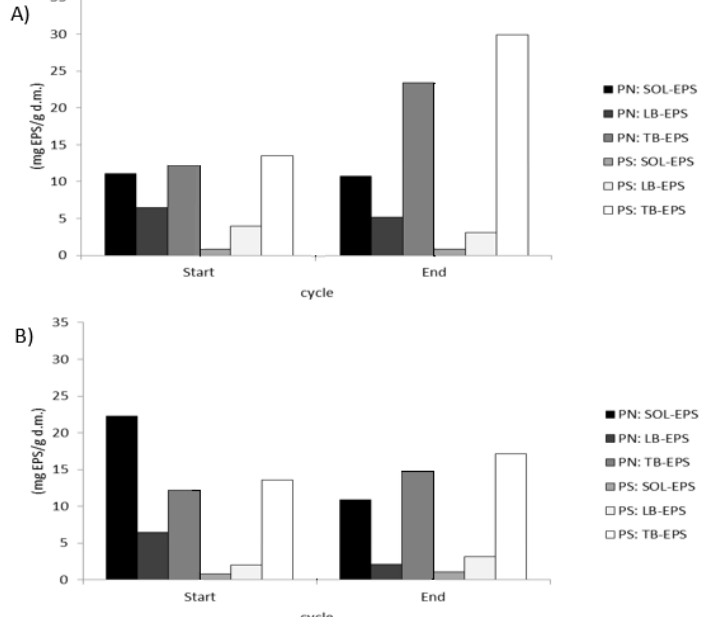
Figure 6. Content and composition of EPS in granules at the beginning and end of the reactor cycle in ( A ) R 1 and ( B ) R 2.